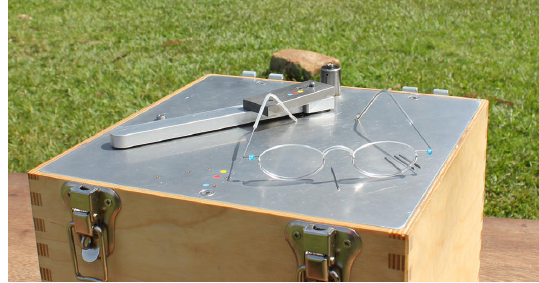
Figure 4. OneDollarGlasses and bending machine (2012).